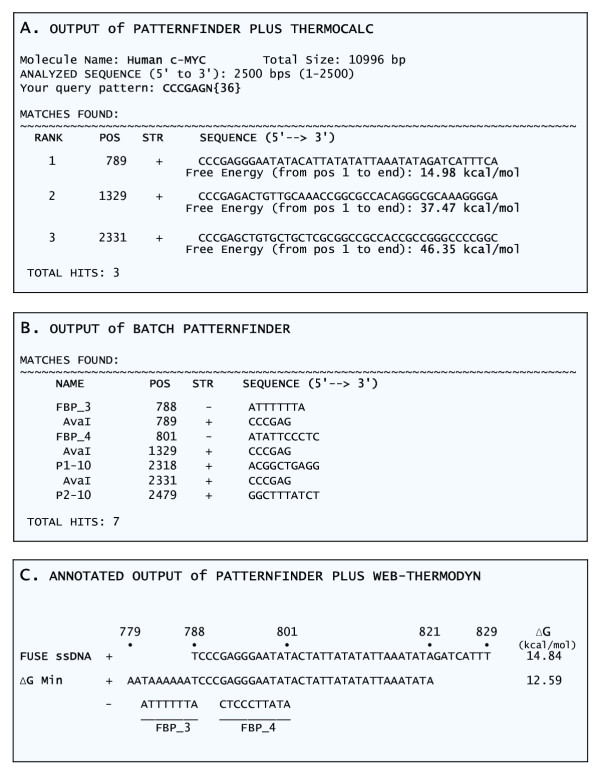
Examples of analysis of the human c-myc gene regulatory region using PATTERNFINDER in conjunction with THERMOCALC (A), in BATCH mode (B), and with WEB-THERMODYN (C) [see text].